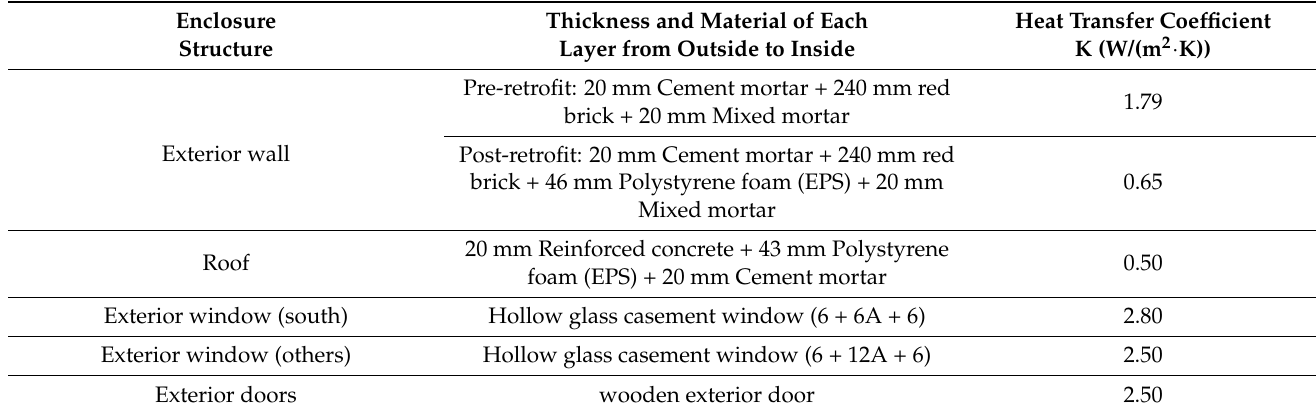
Table 1. Heat transfer coefficient settings of the simulation